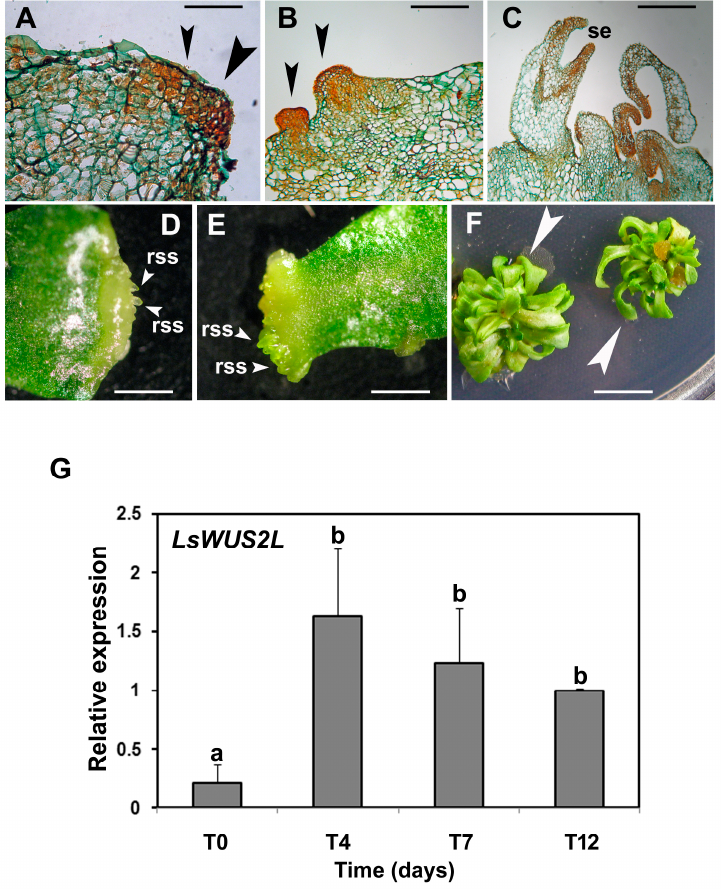
Figure 3. In vitro regeneration of Lactuca sativa cv. ‘Romana’ on a regeneration medium with 2.2 μ M of 6-benzylaminopurine and 0.54 μ M of α -naphthalenacetic acid; time-dependent analysis of WUSCHEL2-LIKE ( LsWUS2L ) expression levels. ( A – C ): Histological analysis of cotyledon explants cultivated in vitro. Explants sectioned after 4 [T4 ( A )], 7 [T7 ( B )], and 12 [T12 ( C )] days of culture on the regeneration medium. ( A ) Longitudinal section of a callus area characterized by small and poorly vacuolated cells located in a marginal region (black arrowheads). ( B ). Longitudinal section of an explant with initial stages of adventitious structures (black arrowheads). ( C ). Longitudinal section of an explant with early-stage somatic embryos (se). Scale bars: 0.7 mm ( A ), 0.19 mm ( B ), 0.28 mm ( C ). Binocular microscope photos of cotyledon explants in regeneration. ( D ), ( E ) Explants after 7 days (T7) of culture on regeneration medium: regeneration events occurred with the appearance of round-shaped structures (rss, white arrowheads) characterized by a regular profile. ( F ) Explants with massive formation of well-organized regenerated plantlets (white arrowheads). Scale bars: 0.85 mm ( D ), 1.02 mm ( E ), 8.7 mm ( F ). ( G ) Time-course analysis of the expression of WUSCHEL2-LIKE ( LsWUS2L ) during in vitro regeneration from cotyledon explants of lettuce. The times of in vitro culture analyzed were: T0 (0 days), T4 (4 days), T7 (7 days), and T12 (12 days). The relative transcriptional values were calculated using T12 as the reference sample. Data are means ± standard deviation (SD) ( n = 4). Different letters indicate statistically significant differences between genotypes (one-way ANOVA and Tukey’s test: p < 0.05)